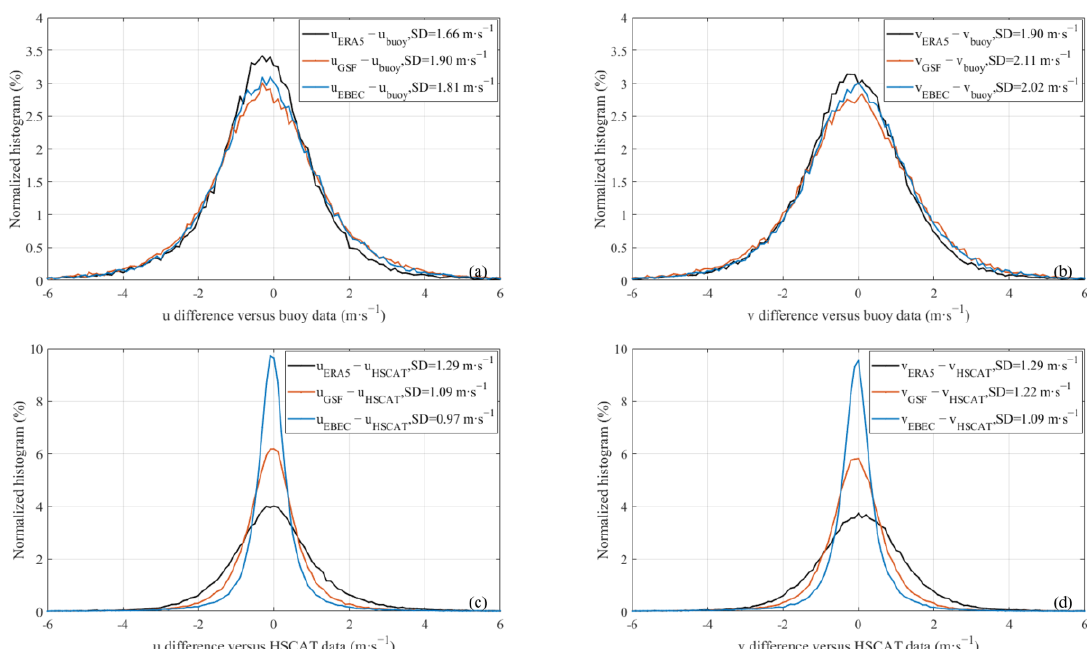
Figure 7. The normalized histograms of wind u ( a ) and v ( b ) differences for ERA5 versus buoys (black), GSF-derived results versus buoys (red), and EBEC derived results versus buoys (blue), respectively. ( c , d ) are the same as the upper panels separately, but using the HSCAT winds as reference. Table 5. SD scores of the blended winds with regards to. buoy